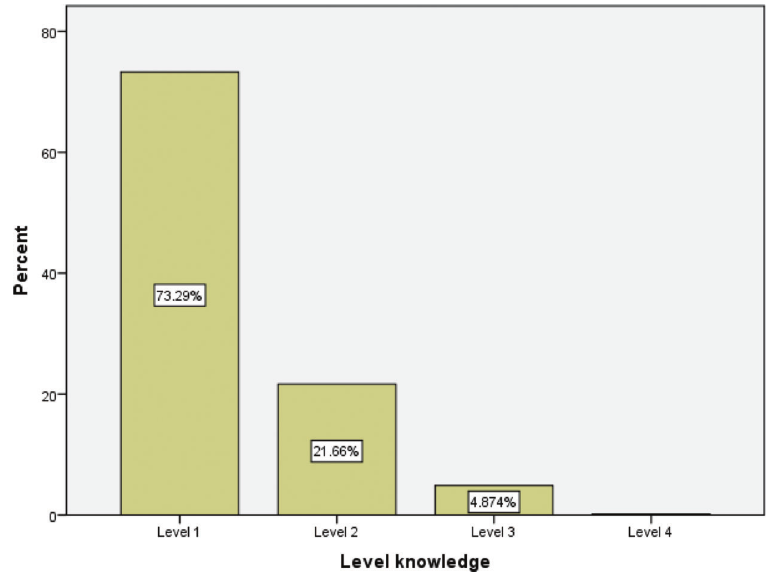
Figure 1 - Students ’ knowledge of mechanical ventilation. Level 1: p 25% of the score, Level 2: 4 25% but p 50% of the score, Level 3: 4 50% but p 5% of the score, Level 4: 4 75% to 100% the score.